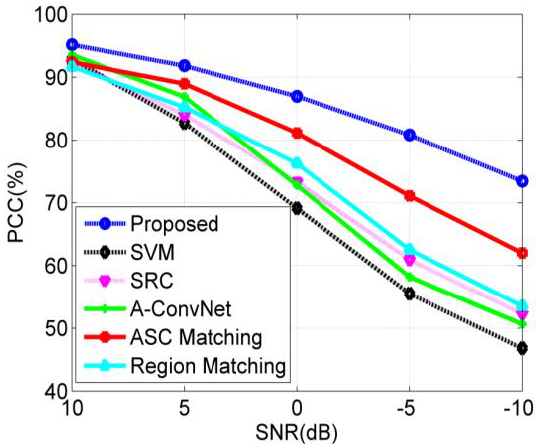
Figure 12. Performance comparison of all the methods under noise contamination.